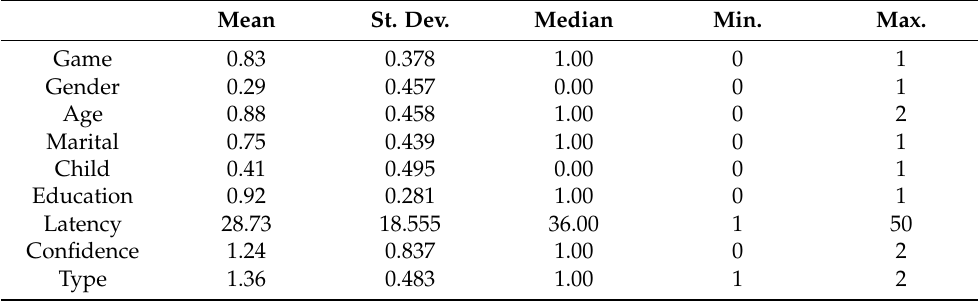
Table 1. Descriptive Statistics.